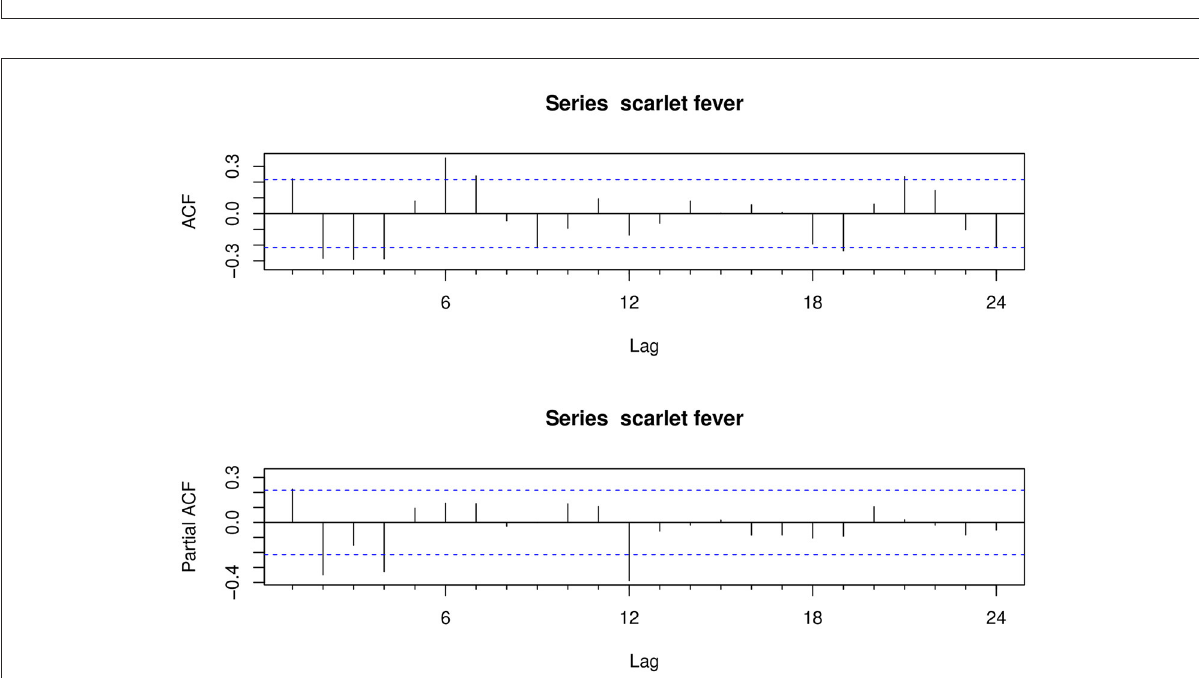
FIGURE4 Autocorrelation and partial autocorrelation plots for the differenced scarlet fever time series.